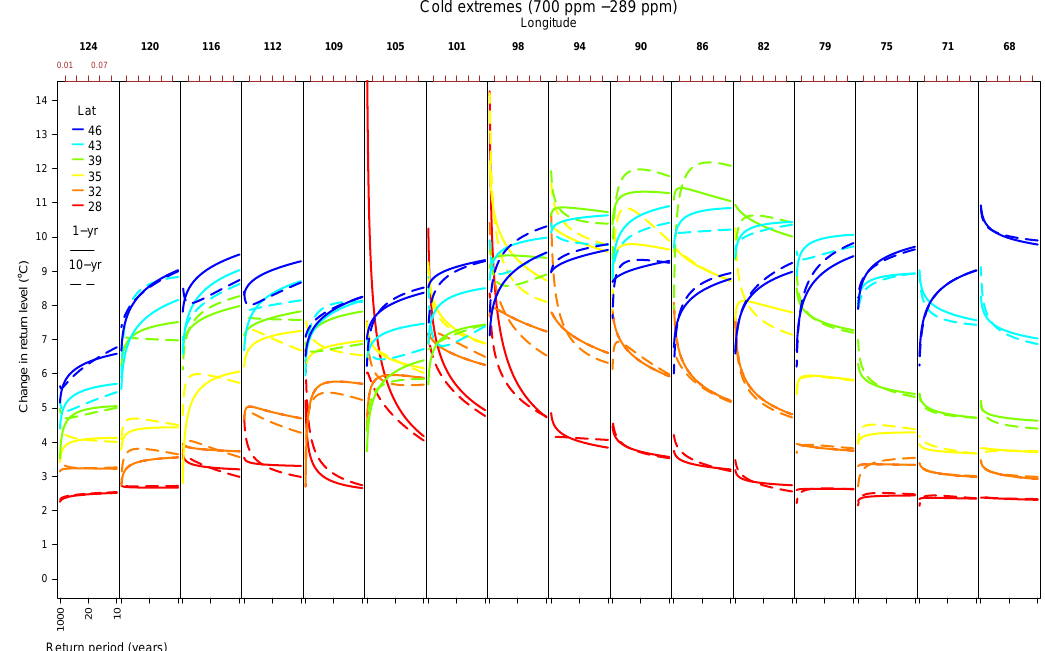
Figure C4. As in Fig. 8 (upper panel) but here comparing the estimated changes obtained from using annual minima (solid lines) vs. decadal minima (dashed lines). The results imply that annual blocks may be long enough to study the changes in cold